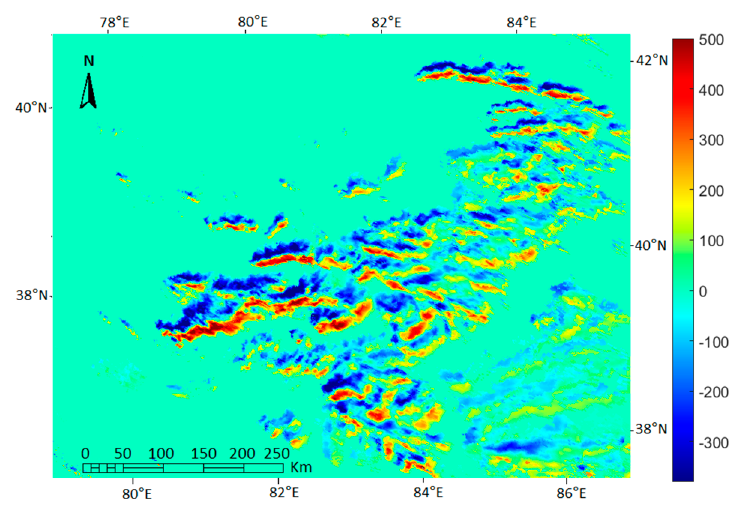
Figure 4. Difference map of SWDR (W/m 2 ). (Corrected SWDR minus original one wherein solar-cloud-sensor geometry is not considered).